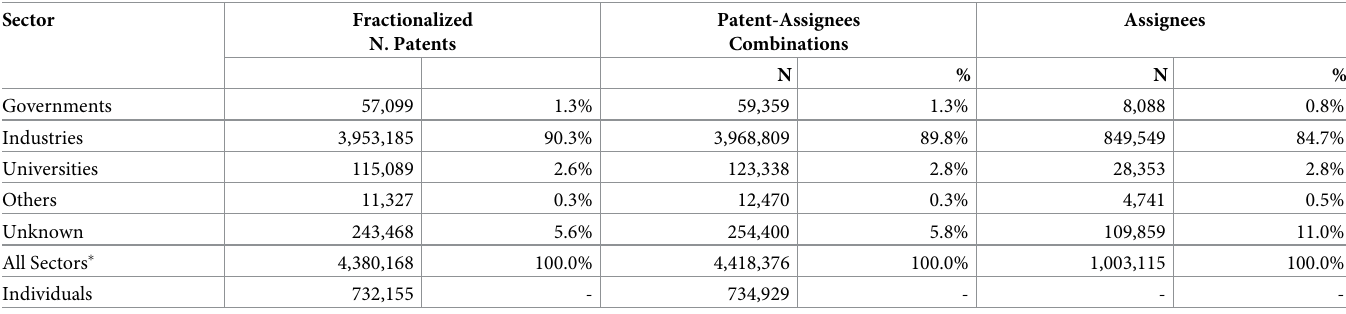
Table 2. Sectoral assignation of fractionalized numbers of patents, of patent-assignees combinations and of distinct assignees. Sector Fractionalized N. Patents